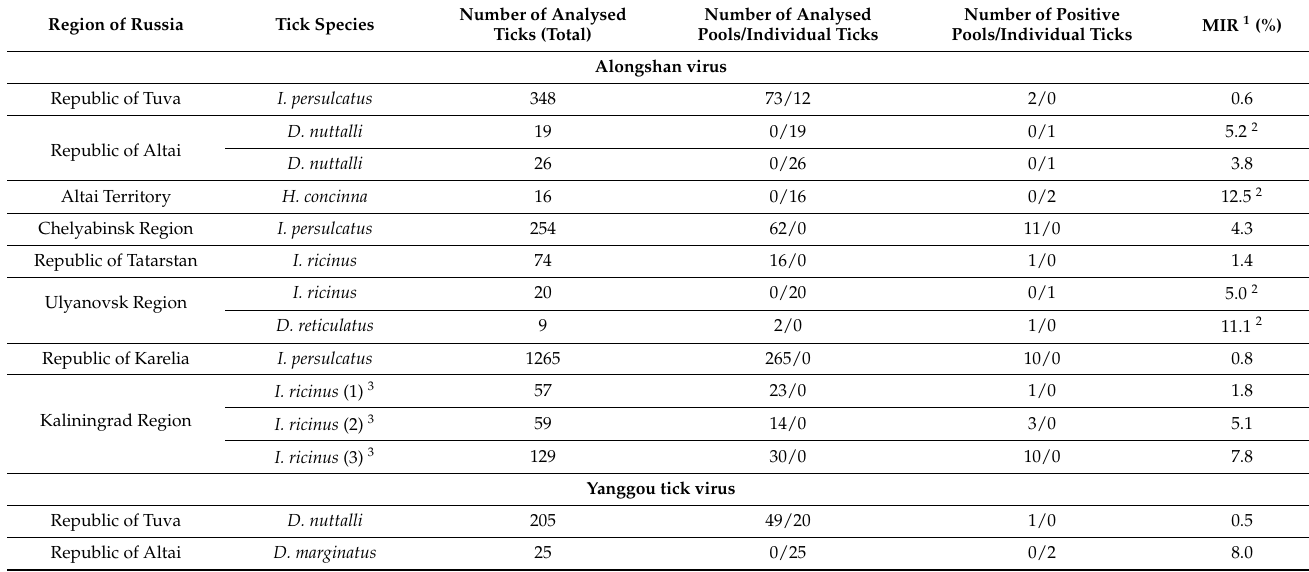
Table 2. Virus prevalence in Ixodes persulcatus, Ixodes ricinus, Dermacentor nuttalli, Dermacentor reticulatus, Dermacentor marginatus and Haemaphysalis concinna ticks collected in different regions of